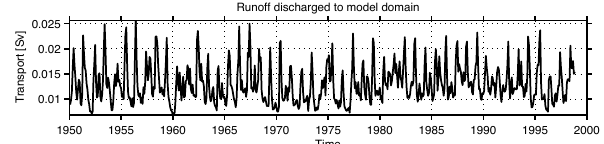
Fig. 2. Vertical model grid. The nominal box thicknesses ( ∆ z ) as a function of depth.